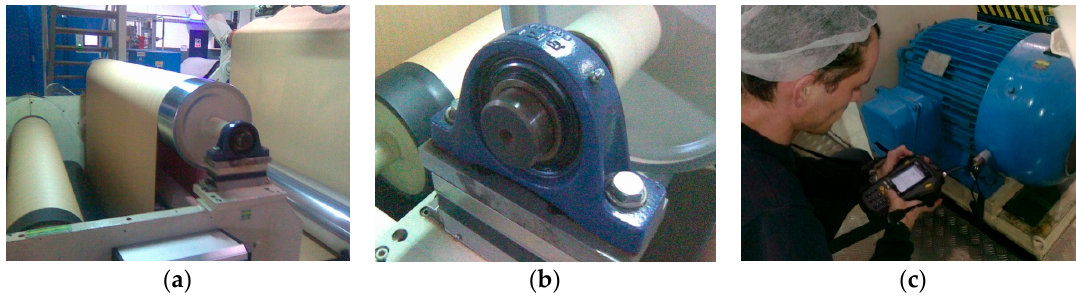
Figure 1. Roller ( a ); bearing ( b ); and electric motor ( c ).